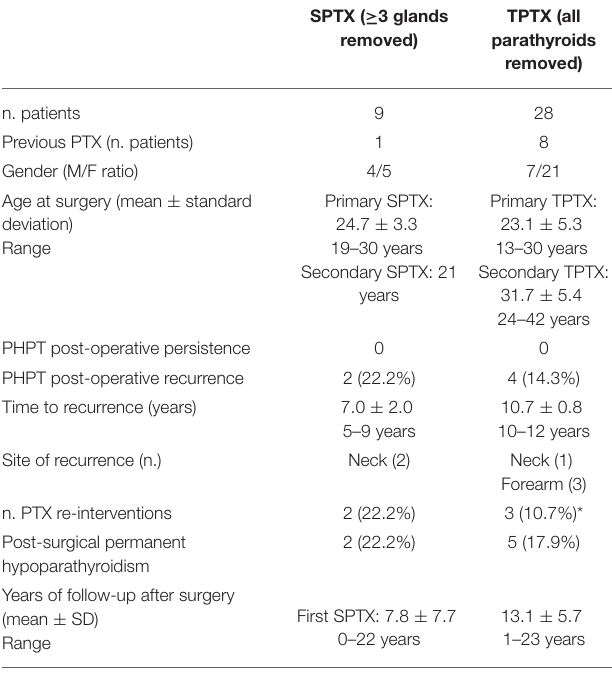
TABLE 1 | Clinical characteristics, type of surgery, and post-surgical outcomes of 37 young MEN1 patients who underwent SPTX or